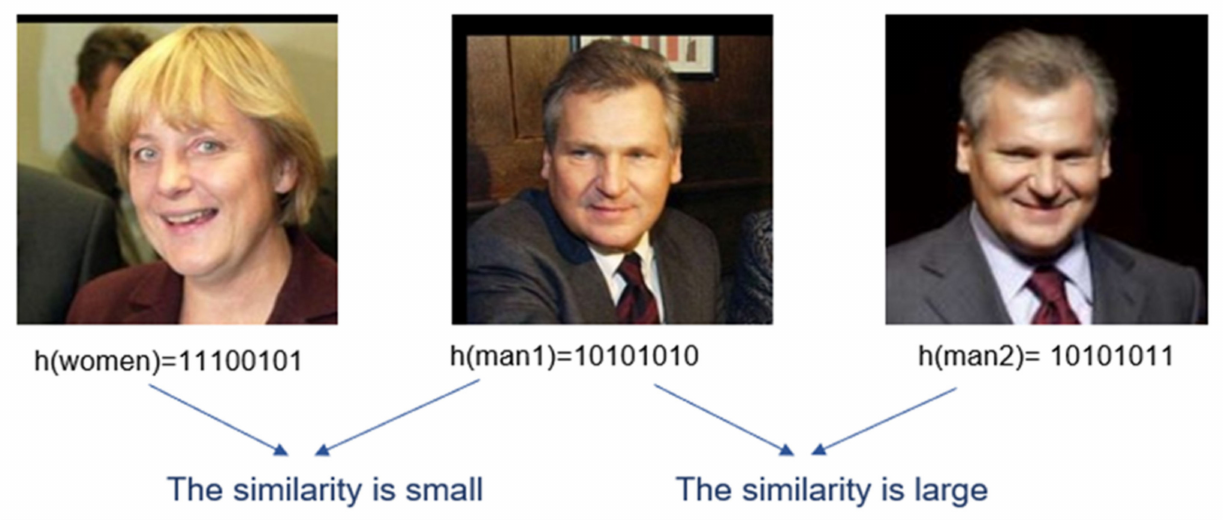
Figure 3. Hash and image